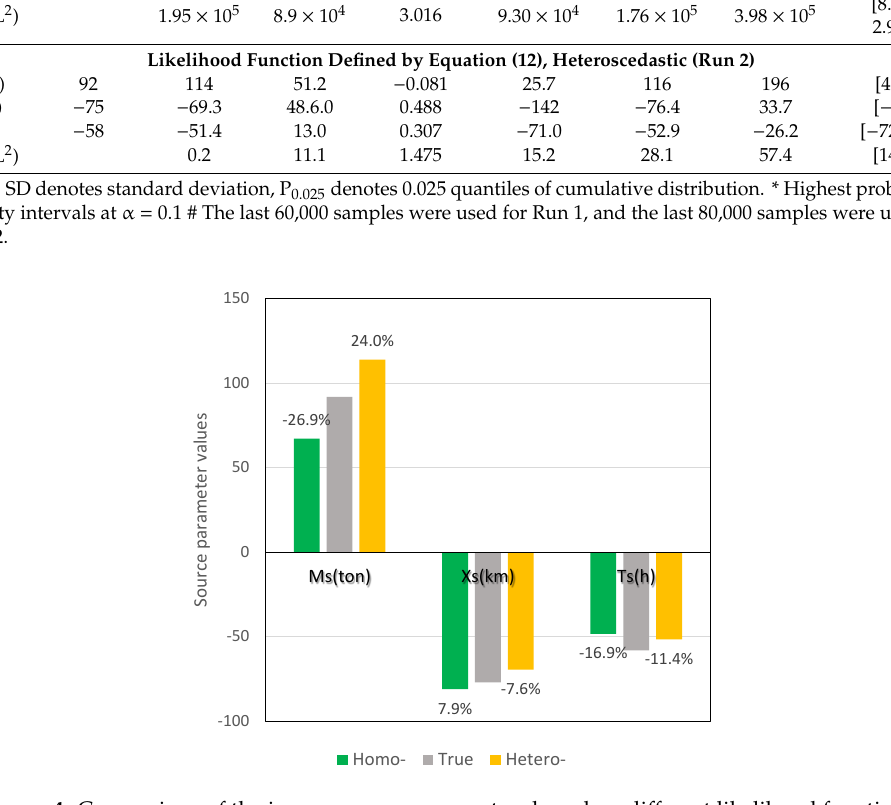
Figure 4. Comparison of the inverse source parameters based on di ff erent likelihood